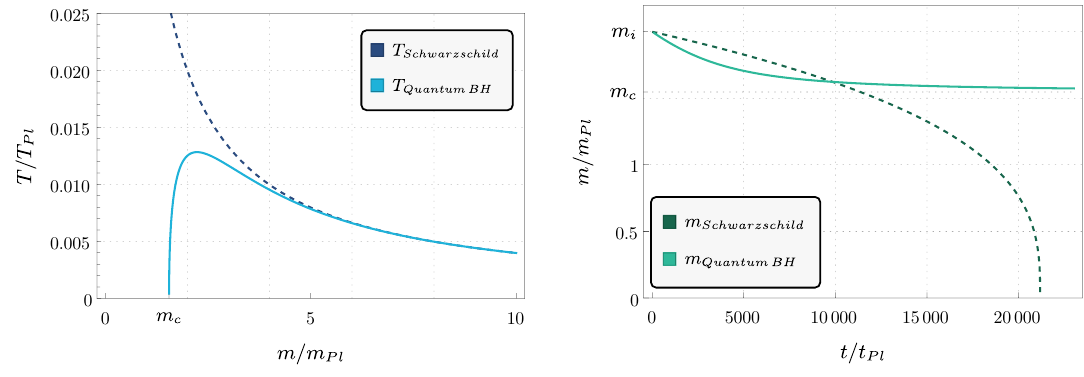
Figure 8 . Temperature and mass of an evaporating classical and quantum black hole. All quantities are in Planck units. The left panel depicts the temperature of the quantum black hole (solid blue line) compared to the classical Hawking temperature of a Schwarzschild black hole (dashed dark blue line). The temperature is displayed as a function of the black hole mass. In the classical evaporation process, the black hole becomes hotter and hotter, leading to a complete evaporation which eventually leaves the classical singularity naked after a finite amount of time. In the quantum version, the temperature at first increases as the mass decreases. However, in contrast to the classical case, it reaches a maximum and then slowly goes to zero. The right panel shows the black hole mass as a function of the proper time measured by an observer at infinity. The function m ( t ) is determined by solving eq. (6.7) numerically, with the initial value m (0) set to m = 2 > m and with i ≡ m i /m Pl c σ ≡ 1 . The dashed dark green line corresponds to the classical case, and shows that the evaporation process occurs in a finite amount of time. By contrast, in the quantum-corrected model (solid green line), a black hole with initial mass m requires an infinite amount of proper time to convert the i mass ( m ) into Hawking radiation, eventually leading to a black hole remnant with mass m i − m c c (dotted black